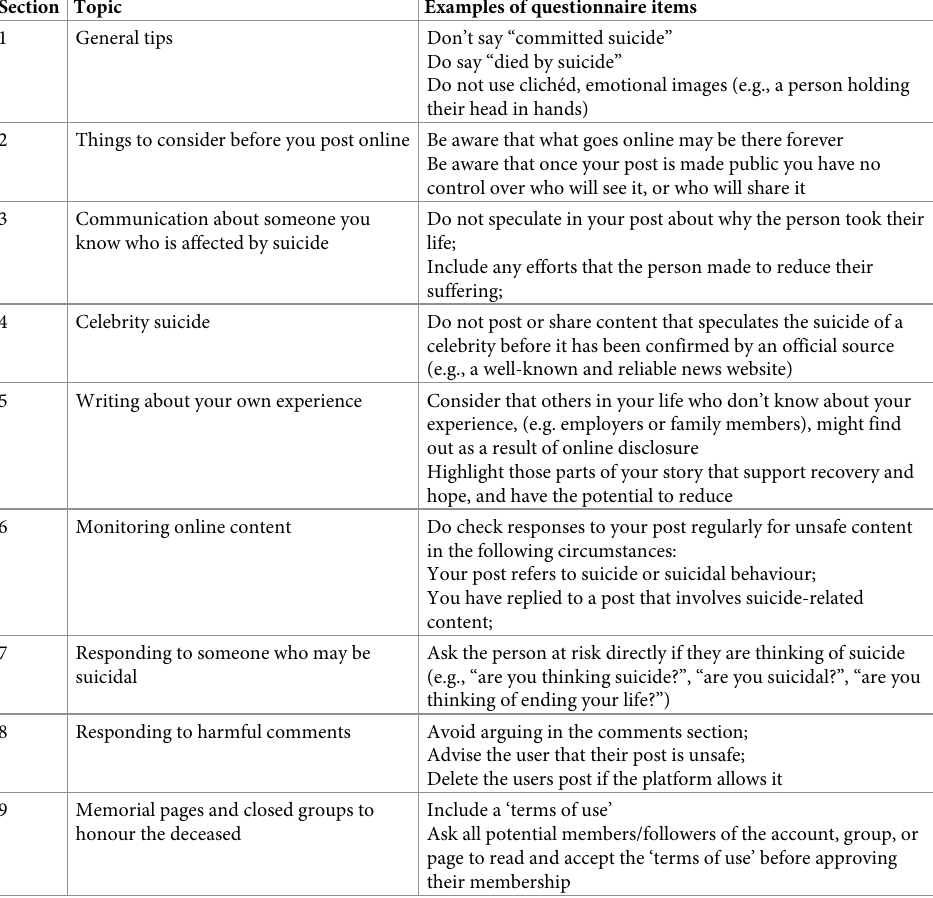
Table 1. Sections included in the Delphi questionnaire and example